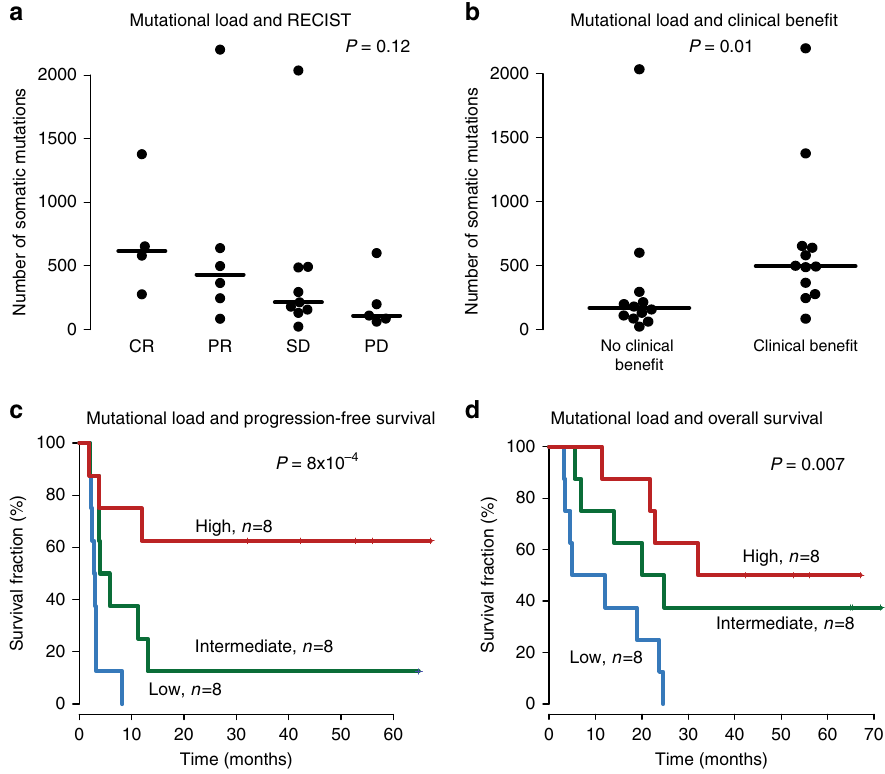
Fig. 2 Mutational load is associated with bene fi t from ACT in melanoma. a Tumor mutational load by clinical response according to RECIST. P -value from Kruskal – Wallis test. Solid black line indicates the median. b Mutational load by clinical bene fi t groups, as de fi ned in Methods section. P -value from Mann – Whitney test. c Tumor mutational load is signi fi cantly associated with progression-free survival, when the cohort in divided into three groups by mutational load. P -value from Cox regression. d Tumor mutational load is signi fi cantly associated with overall survival, when the cohort in divided into three groups by mutational load. P -value from Cox regression. RECIST categories: CR complete response; PD progressive disease; PR partial response; SD stable